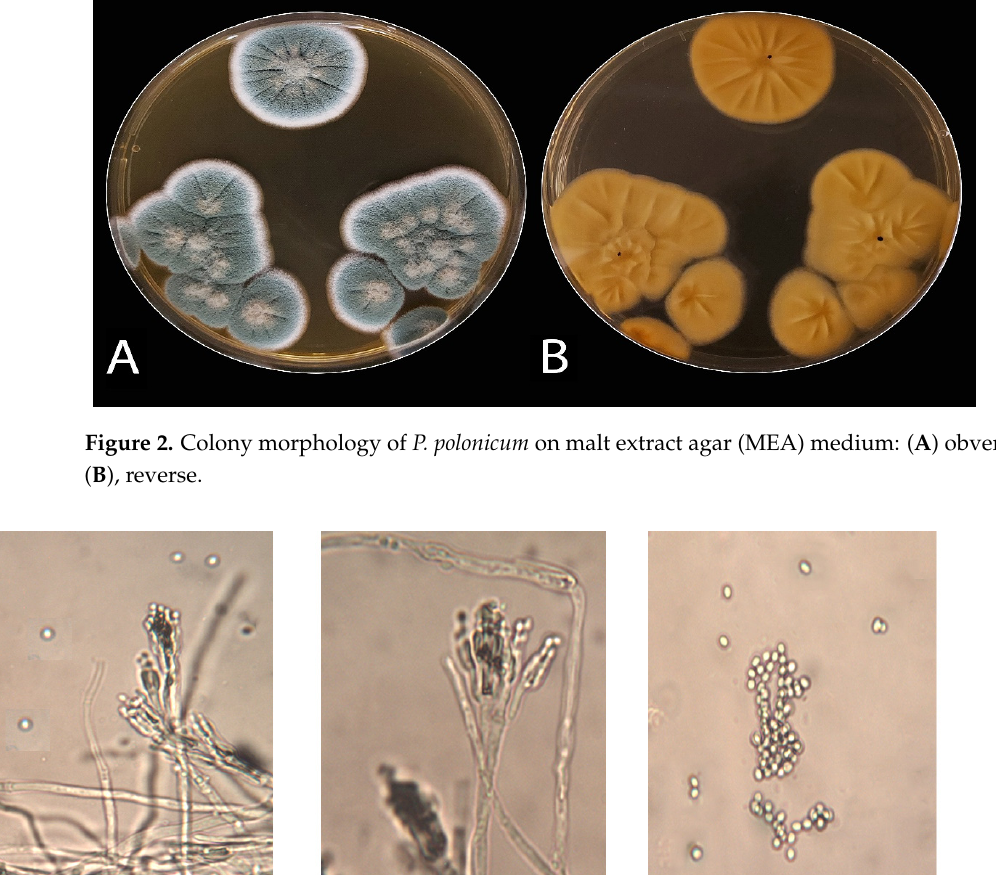
Figure 3. Microscopic micrograph of P. polonicum shows the typical terverticllate conidiophores ( A , B , at ×400) with smooth septate stripes and the spherical conidia ( C , at ×400).